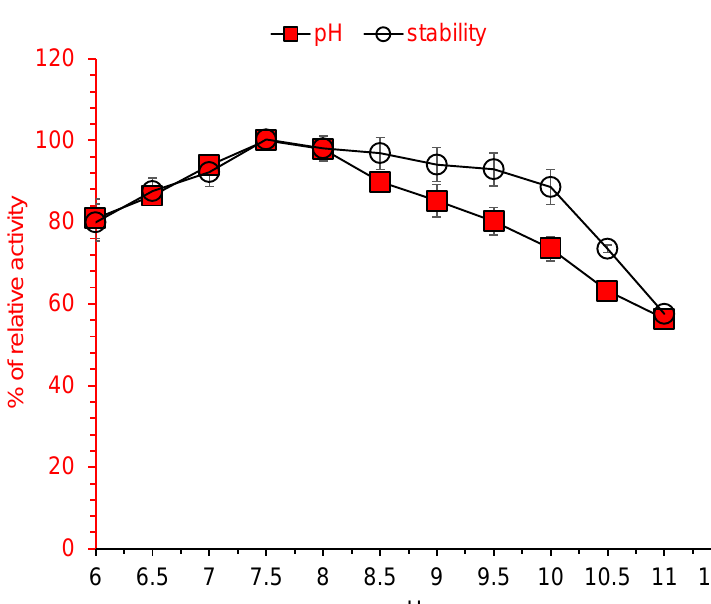
Figure 6. The effect of pH on amylase activity and stability produced by Bacillus sp. BCC 021-50. The pH of the enzyme reaction was adjusted in the range of 6–11 with the addition of different buffers. Results are the average of triplicate experiment.